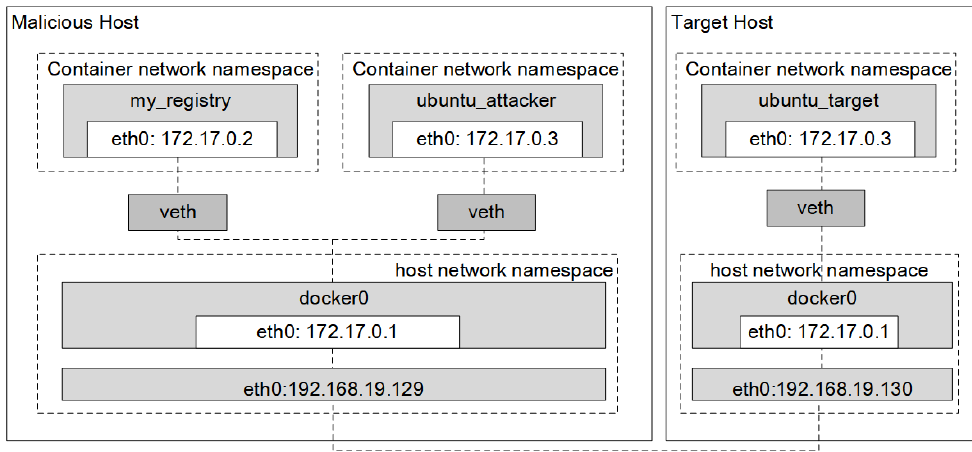
Figure 15. Experimental environment of privilege